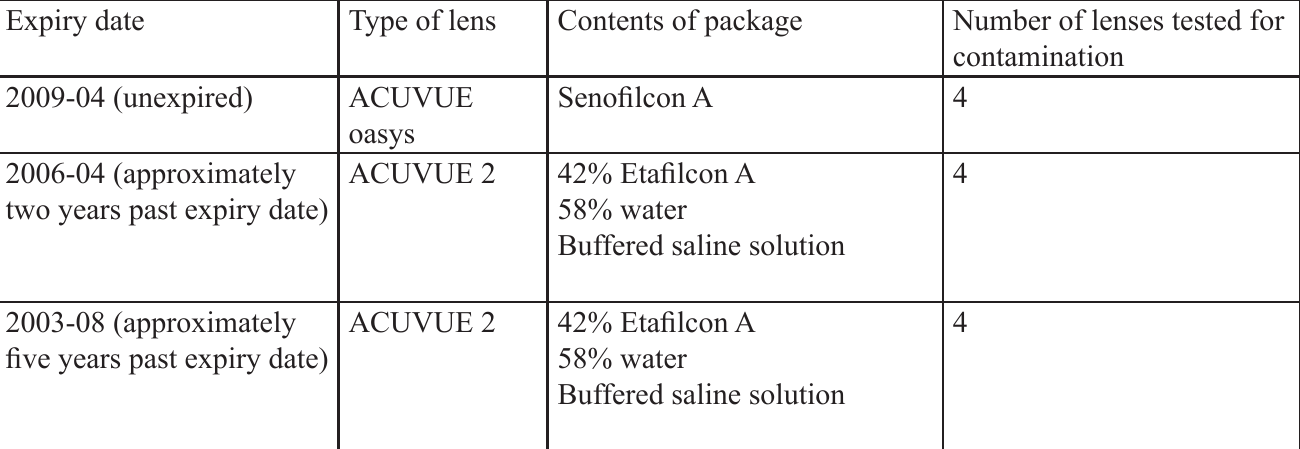
Table 1: Details of Johnson and Johnson blister pack contact lenses